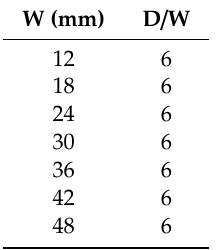
Table 2. Group 2: Constant aspect ratio without center hole (D = 0).